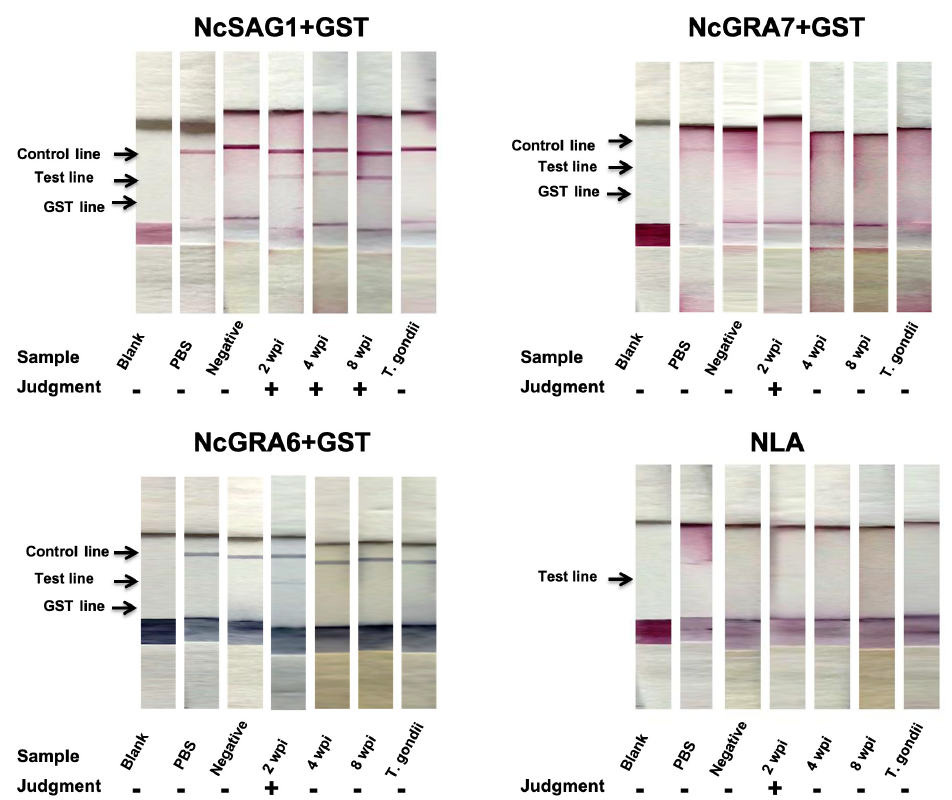
Figure 2. Immunochromatographic test (ICT) assay results against experimental mouse sera. A representative strip for each group of samples is illustrated for tested antigens. Blank, no treatment ( n = 1); PBS, treated by PBS ( n = 1); Negative ( − ), non-infected mouse sera ( n = 5); positive (+), 2 wpi, mouse serum samples at 2 weeks post-infection ( n = 5); 4 wpi, mouse serum samples at 4 weeks post-infection ( n = 5); 8 wpi, mouse serum samples at 8 weeks post-infection ( n = 5); T. gondii , sera from T. gondii -infected mice ( n = 3). “ − ” or ”+” on graph indicates no or appearance of test band reactivity of the strip. Table 1. Summary of enzyme-linked immunosorbent assay (ELISA) and immunochromatographic test (ICT) results.